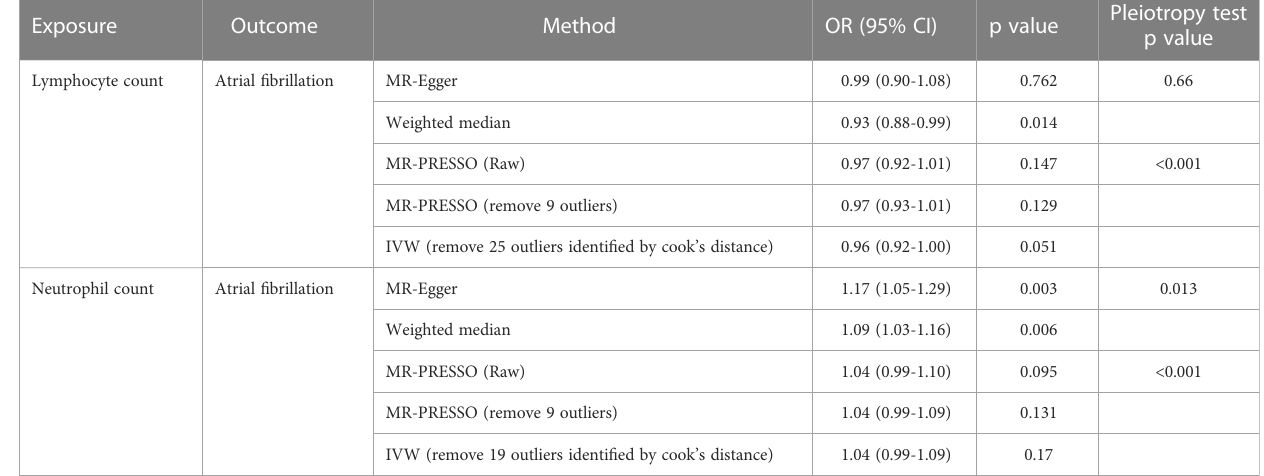
TABLE 1 Sensitivity MR analyses evaluating the causal effects of neutrophil and lymphocyte counts on atrial fi brillation.